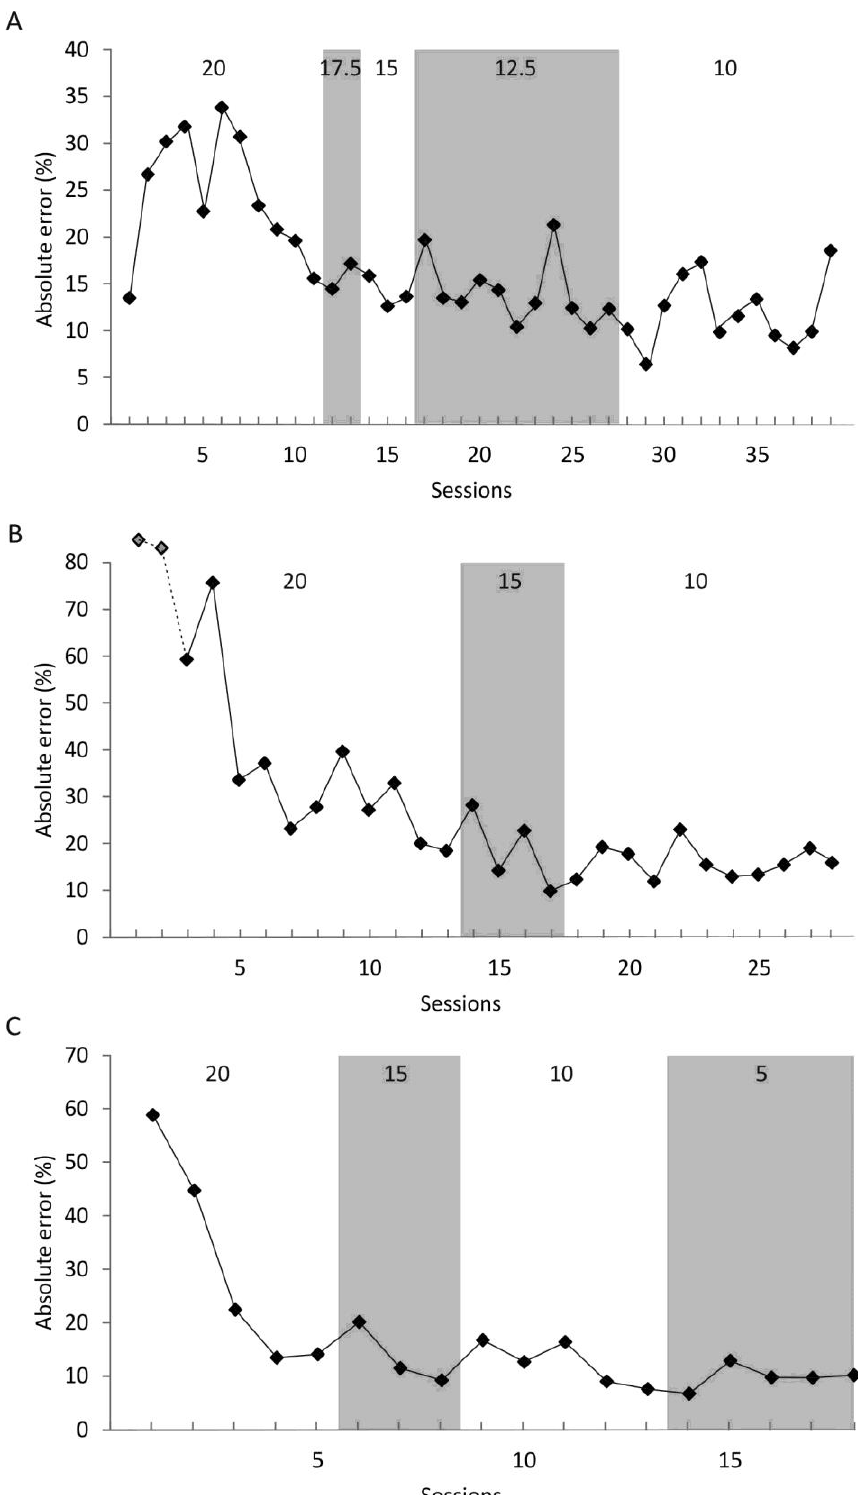
Figure 3. Results of experiment 2. Average absolute error for each session conducted: ( A ) 9 m distance; ( B ) 2 m distance; ( C ) 13 m distance. Every data-point depicts the average absolute error during one session with pseudorandomized SPs. Experimental blocks comprise the performance for the different TR, the seal experienced during the sessions. Due to portrayal issues, we did not illustrate the right scale of the axis for graph B and excluded the to-scale portrayal of the first two values. These values were 360% and 277%.